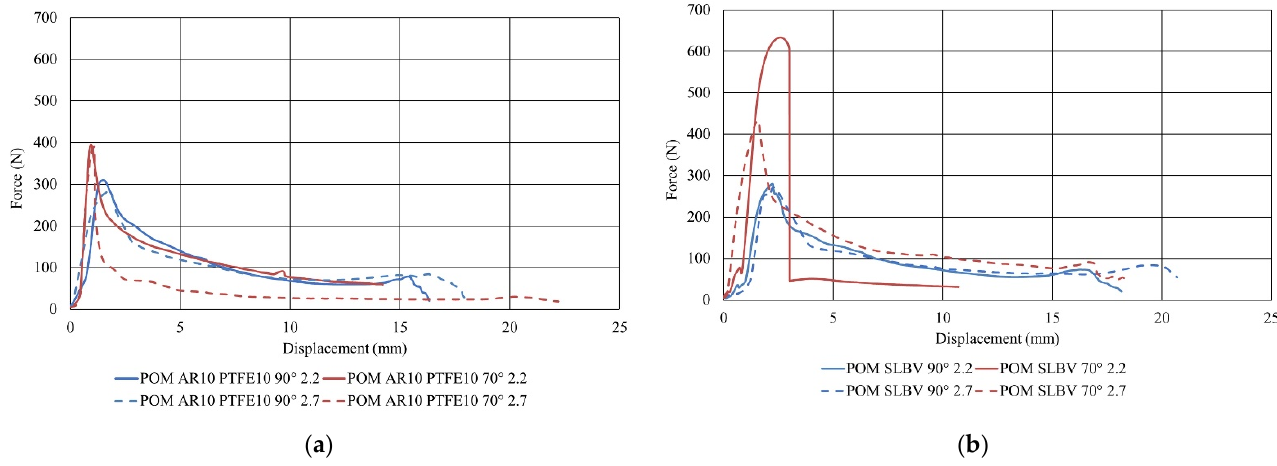
Figure 9. ( a ) Representative force-displacement curves from the peeling tests for different building angles (90 ◦ and 70 ◦ ) and thicknesses (2.2 mm and 2.7 mm) of the plastic layer consisting of POM AR10 PTFE10. ( b ) Representative force-displacement curves from the peeling tests for different building angles (90 ◦ and 70 ◦ ) and thicknesses (2.2 mm and 2.7 mm) of the plastic layer consisting of POM